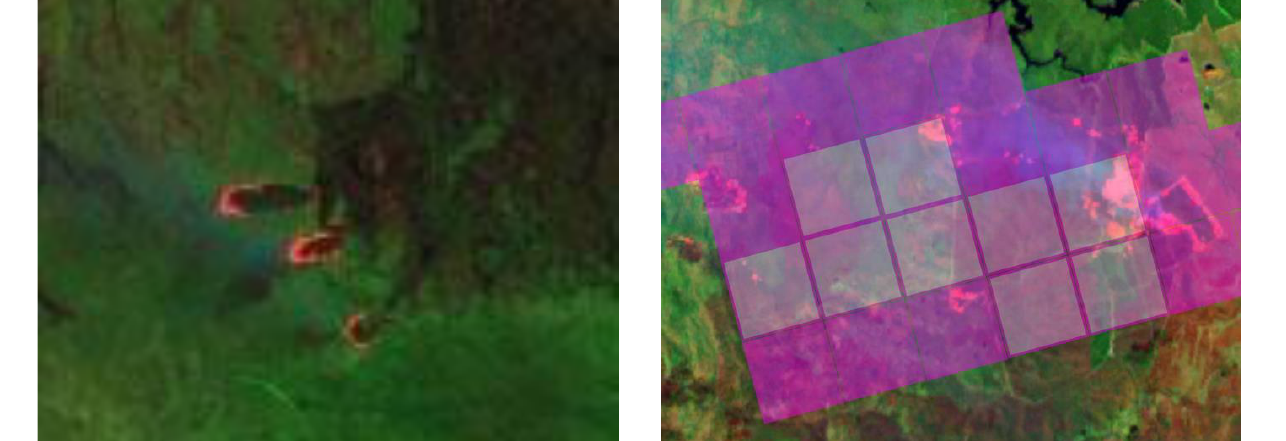
Figure 9. MODIS fire mask overlaid on the real-time Landsat image in the previous figure (dark pink: high confidence, light pink: nominal confidence fire